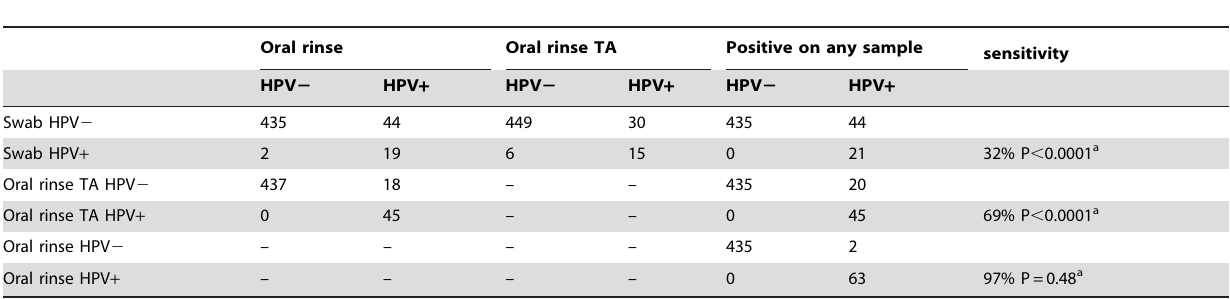
Table 2. Any HPV type detected by oral rinse, tampon-absorbed (TA) oral rinse and self-collected throat-mouth swabs.